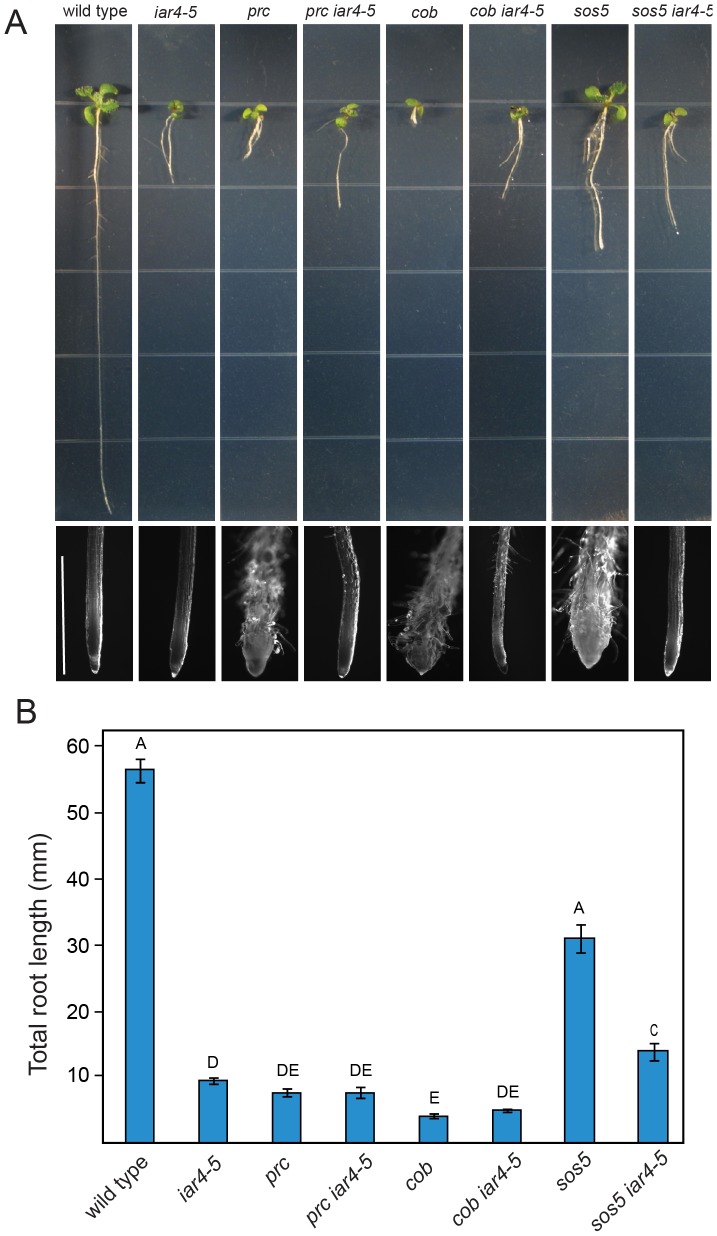
Mutations in iar4-5 suppress other cell wall mutants.(A) Phenotypes of indicated seedlings grown for 14 days on MS medium supplemented with 4.5% sucrose. The bottom is a close-up of the root tips of the seedlings shown above. Scale bar = 1.5 mm (B) Quantification of total root elongation. Plants were grown on MS medium supplemented with 4.5% sucrose for 10 days and total root lengths were measured. Values represent means ± SE (n>17). Different letters indicate significant differences between groups. Data were analyzed with one-way ANOVA and Tukey's post-hoc comparisons; P<0.05.